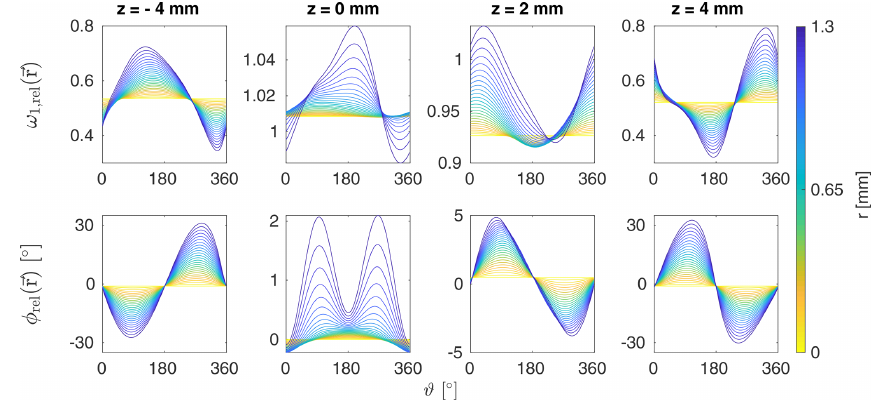
Figure 2. Relative rf amplitude ω 1 , rel and phase φ rel as a function of ϑ for z = -4, 0, 2, and 4mm and all r values in the 3.2mm MAS probe at a resonance frequency of 600MHz. Under MAS, the rf amplitude and phase experienced by a crystallite will vary periodically with the rotor frequency. These time-dependent modulations of the rf field are strongest at the edges of the rotor for large r and z